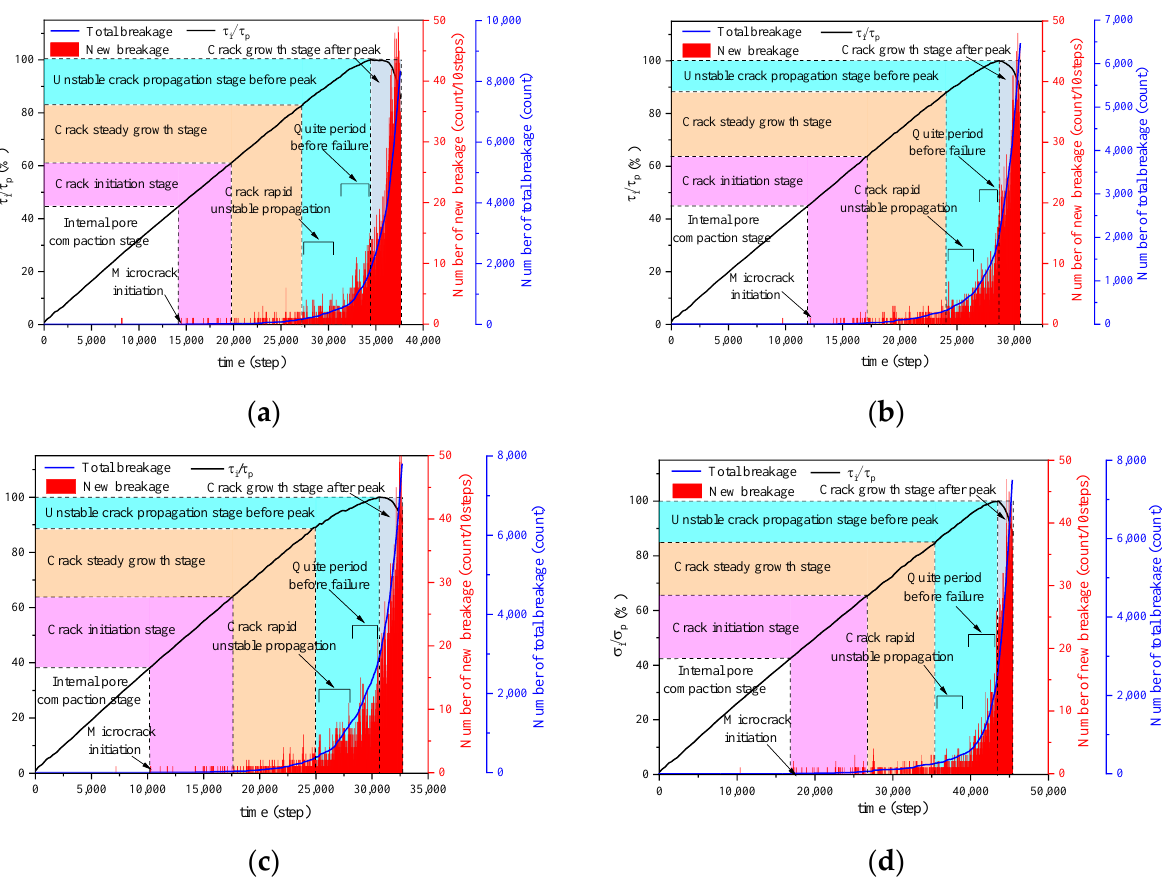
Figure 15. Variation of breakage number with time steps in the loading process of the model: ( a ) Positive shear; ( b ) Reverse shear; ( c ) Lateral shear; ( d ) Intact sample shear. Figure 16 shows the growth of the number of tension-shear breakages and the variation in the proportion of tension-shear breakages in the model loading process. The yellow and purple columns represent the proportion of tensile and shear breakage numbers, respectively, in the corresponding stages. It can be seen from Figure 15 that the number of shear breakages was small in the early loading stage; then, tensile cracks accounted for a large proportion. The proportion of tensile shear breakages in reverse shear and lateral shear was equivalent when τ i / τ p = 50%, while the proportion of tensile shear breakages in forward shear and complete sample shear was equivalent when τ i / τ p = 65%. After that, the proportion of shear breakages increased rapidly, and shear failure occurred until the model was broken